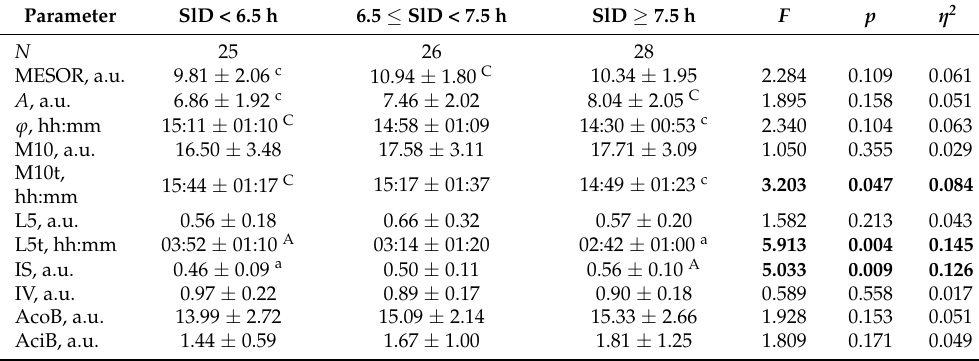
Table 4. Association of sleep duration with 24 h rest–activity rhythm characteristics.